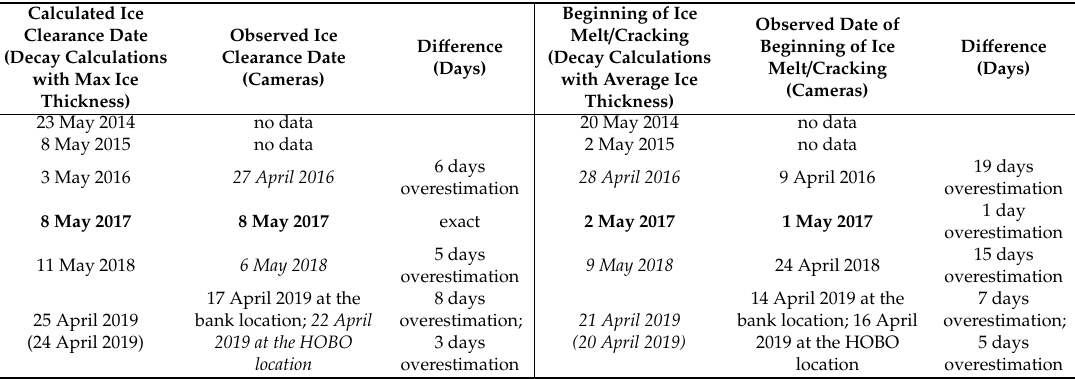
Table 3. The observed (cameras at the bank location) and calculated ice decay / clearance dates based on Equation (2) and the measured maximum and average ice thicknesses during field surveys. The ice clearance date means that there was no more ice in the river on that date. The bolded dates denote when calculations done with the max and average ice thicknesses corresponded the best to the observed dates of ice clearance and beginning of ice melt, respectively. The dates in italics denote when the ice decay calculations done with the average ice thickness corresponded to the observed ice clearance date. Calculated dates within parentheses are based on the HOBO temperature